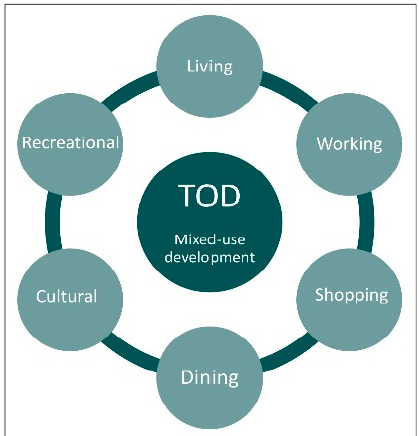
Figure 3. Types of activities typical of a TOD (Source: Calthorpe, P. Adapted from [6].